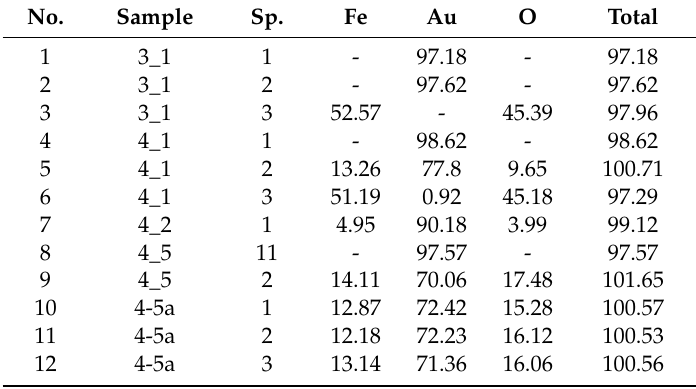
Table 5. The mixed compositions of mustard gold and goethite / hydrogoethite (wt. %) as shown in Figure